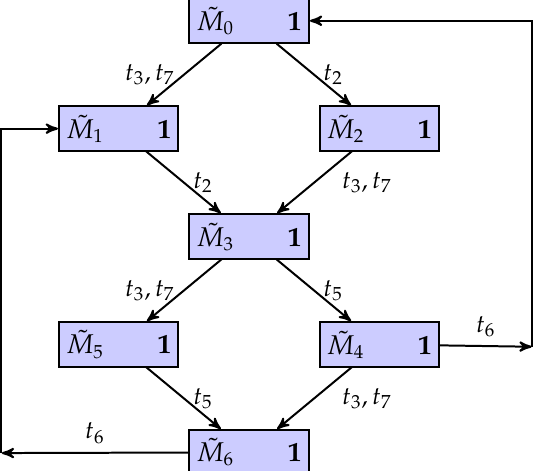
Figure 7. A BCG-based new observer of the unbounded net